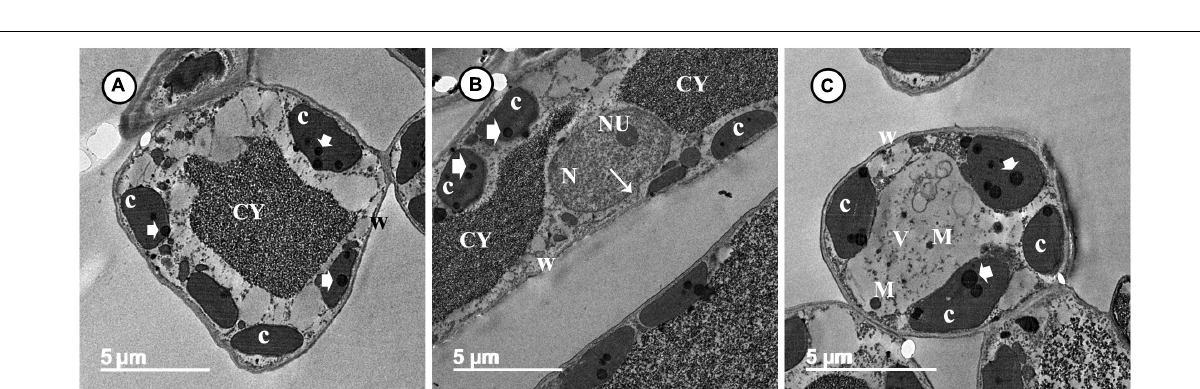
FIGURE 3 | Transmission electron micrographs of grapevine leaf cells infected with P. viticola . Where (A) the cell is completely plasmolized. Note the thick wall (W) and cell membrane (arrow) moved away from the cell wall, and (B) the cell showing a disruption of their components. Note a thick and an electron-dense cell membrane (arrow). Note also abnormal chloroplasts (C), numerous granules (arrowheads), and a thick wall (W). Bar = 5.0 µ m.